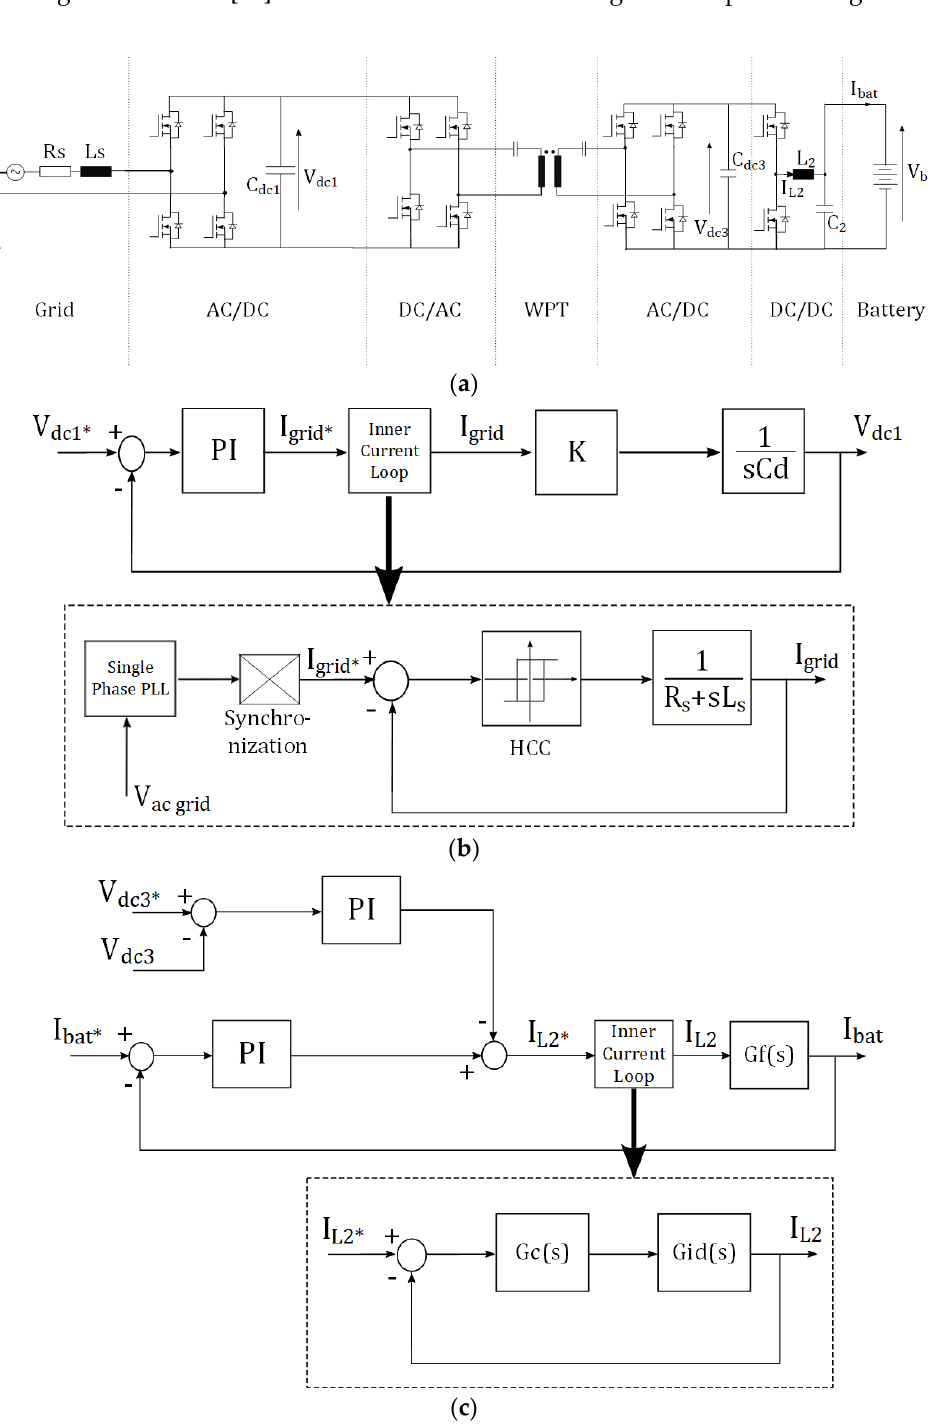
Figure 11. Control method diagram for the WPT system: ( a ) Control strategy for a bidirectional WPT charging system; ( b ) Voltage oriented grid current control; ( c ) Battery current control.